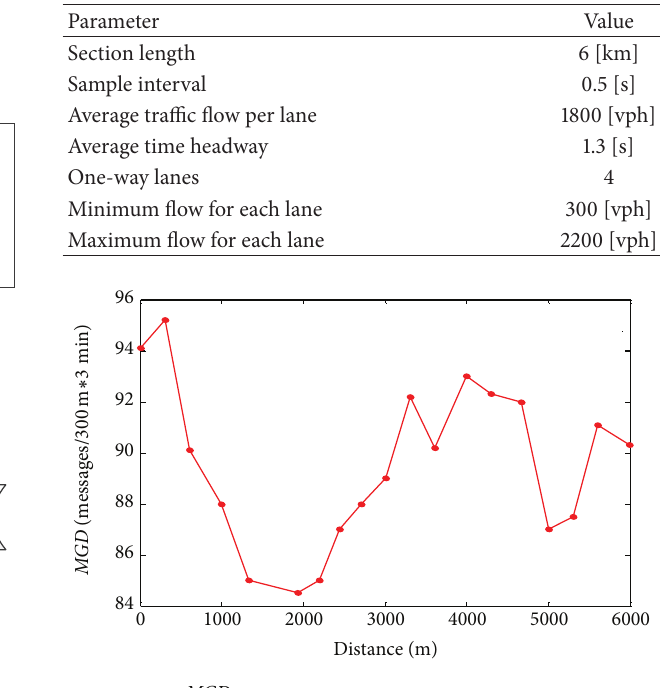
Figure 5: The distance— MGD —on an eight-lane